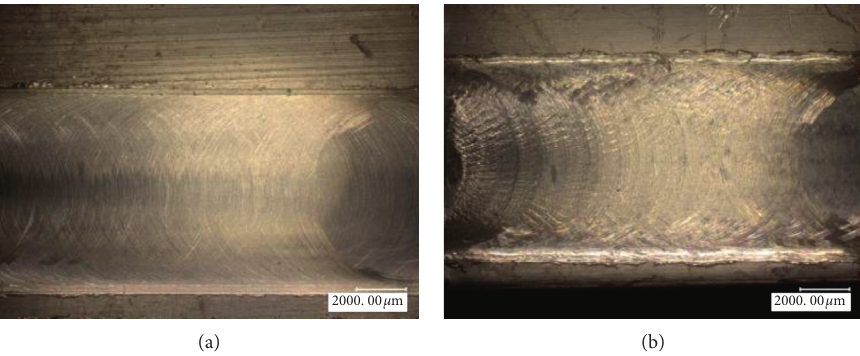
Figure 21: Comparison of workpiece surface topography with 20 times magnification. (a) UVARM. (b)